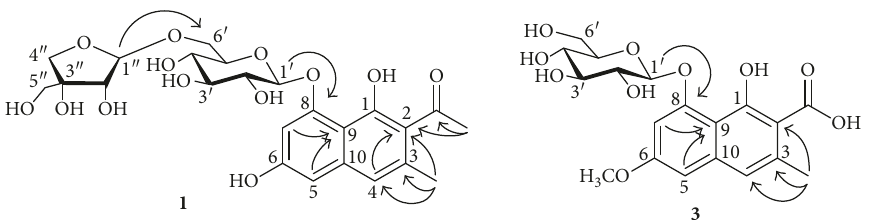
Figure 2: Key HMBC correlations of 1 and 3